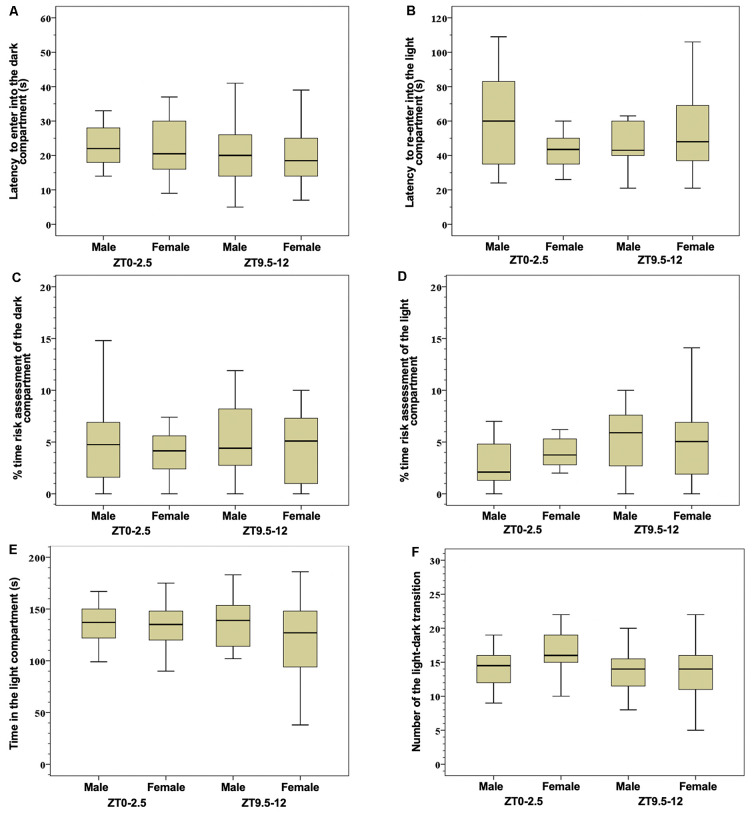
Latency to enter into the dark compartment (A) latency to re-enter into the light compartment (B), % time risk assessment of the dark compartment (C), % time risk assessment of the light compartment (D), time spent in the light compartment (E), and number of the light-dark transitions (F) in the light-dark test. Box-and-whisker plot showing median (horizontal line inside box), 25 and 75 percentiles (edge of box), and 10 and 90 percentiles (whiskers). There were no significant differences between group in the tested parameters.